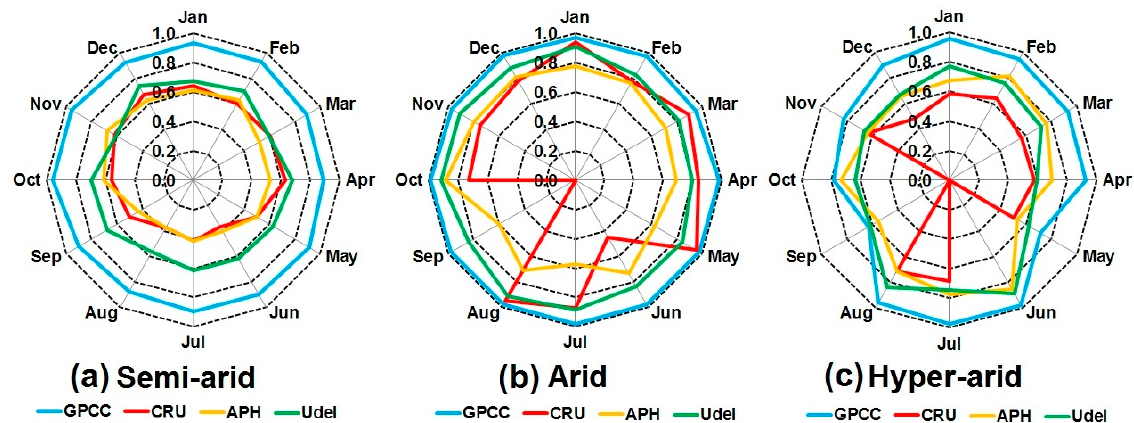
Figure 10. Index of agreement between observed and gauge-based gridded datasets at ( a ) semi-arid, ( b ) arid, and ( c ) hyper-arid station.